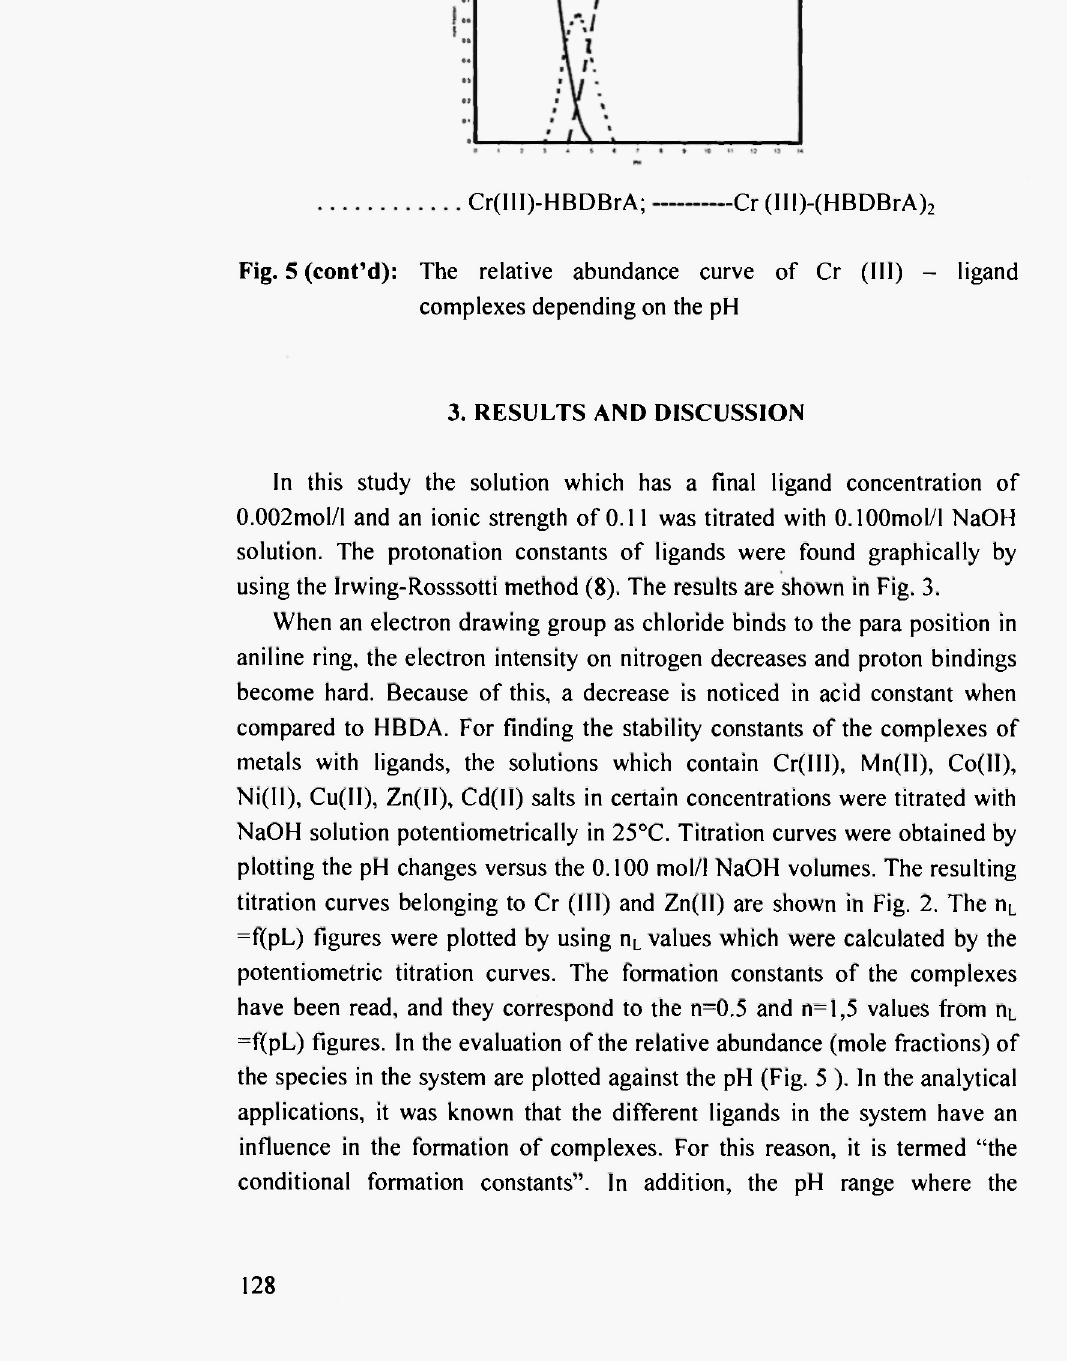
Cr(IlI)-HBDBrA; •Cr (III)-(HBDBrA) 2 Fig. 5 (cont 'd): The relative abundance curve of Cr (III) - ligand complexes depending on the